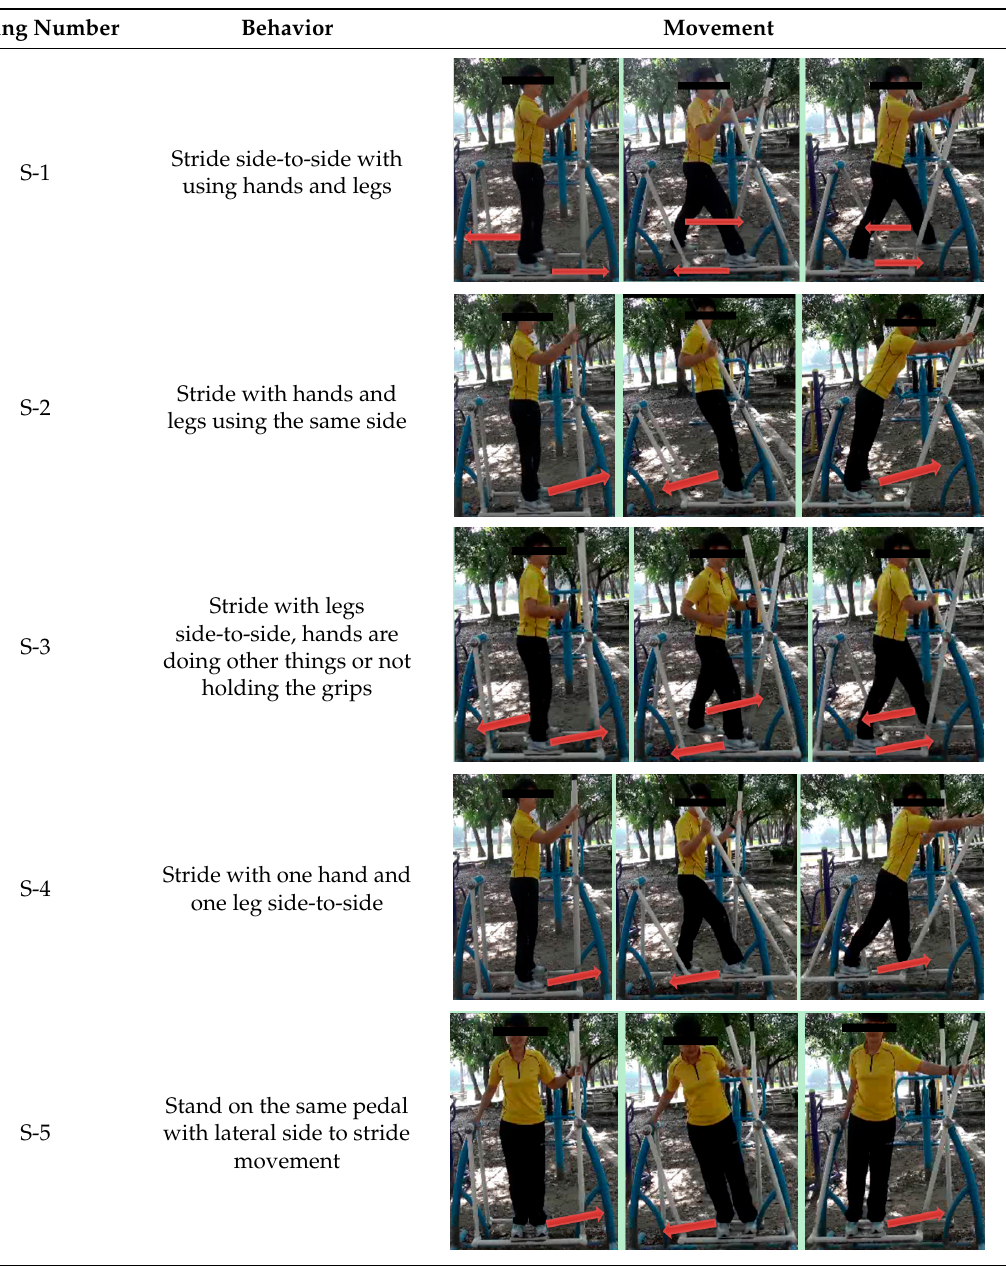
Table A3. Depictions of user behaviors for the ski